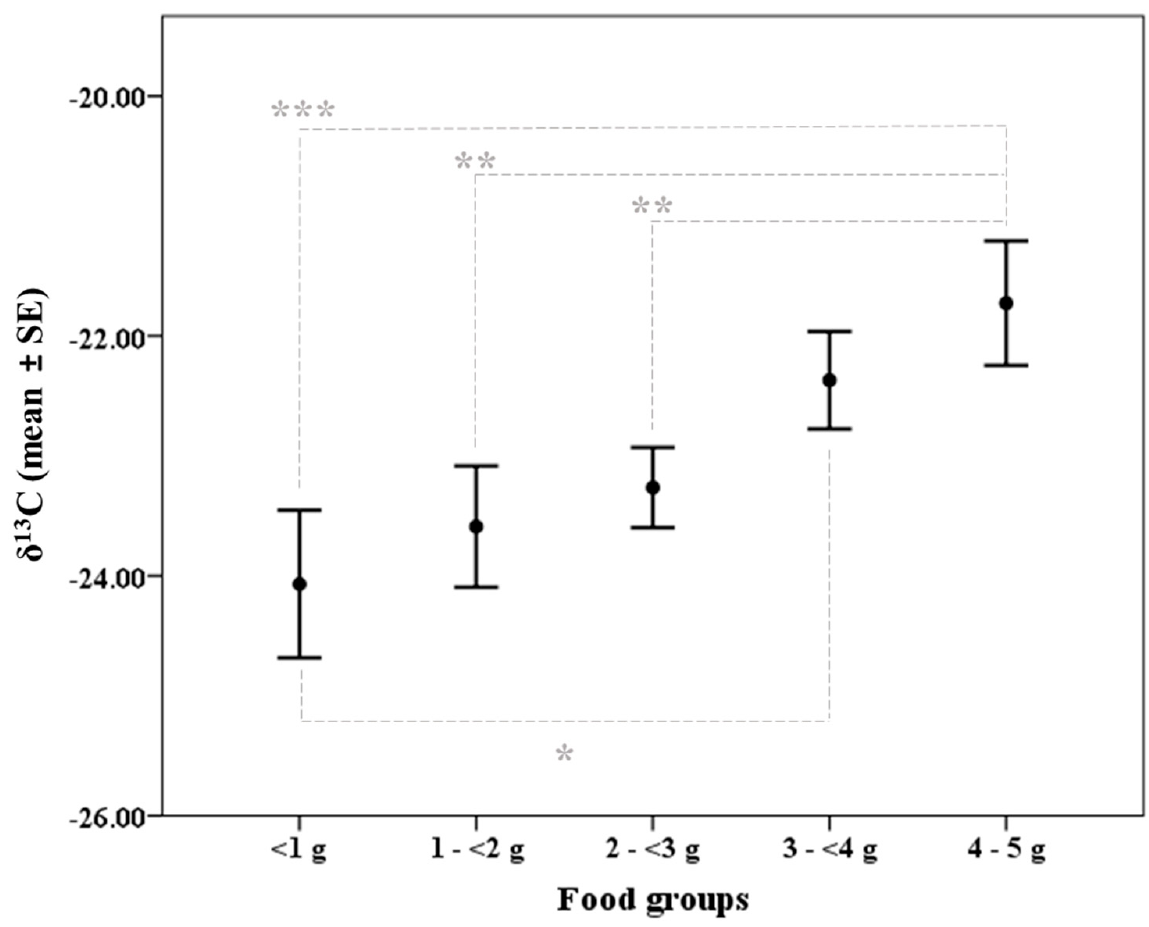
Figure 1. δ 13 C values in relation to food groups. Grey broken lines and associated asterisks indicate significant differences between connected groups (* p < 0.05, ** p < 0.01, *** p < 0.001).